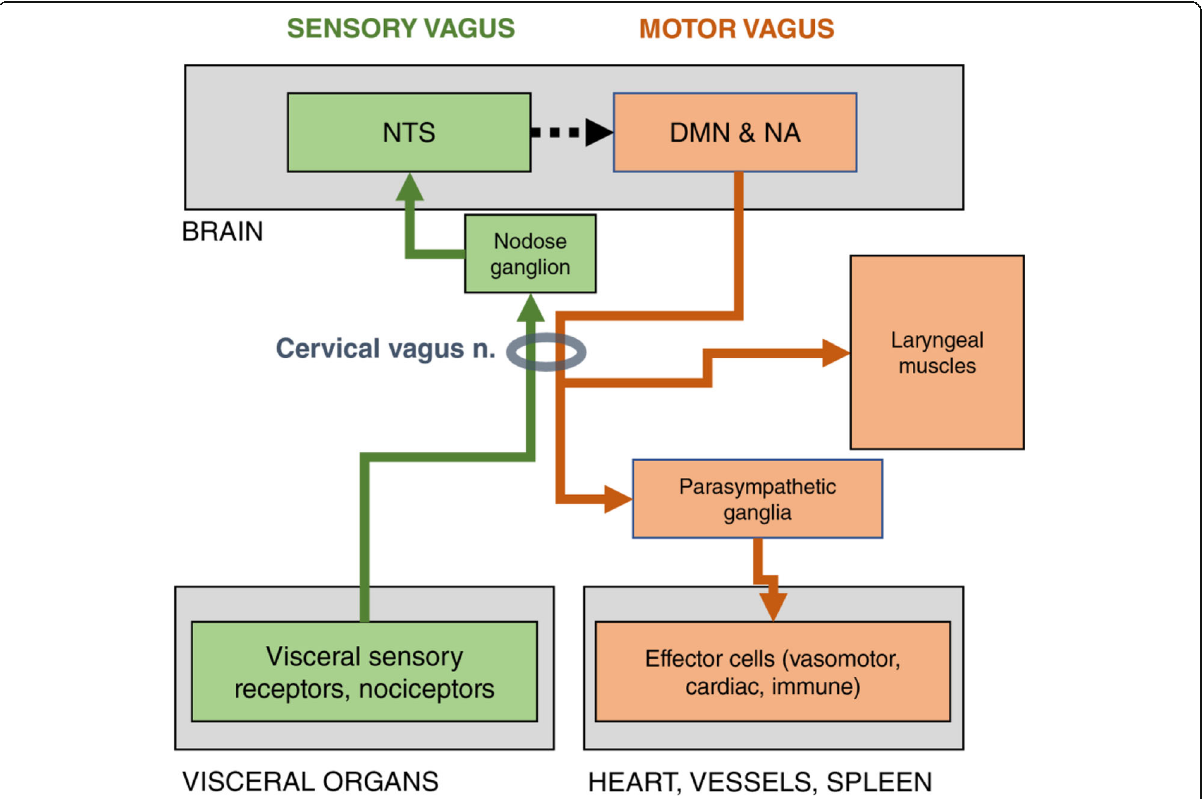
Fig. 1 Schematic diagram of the main central and peripheral components of the motor and sensory vagus. The vagus nerve includes sensory (afferent) and motor (efferent) arms, both of which are represented in the cervical region, where vagus cuffs are typically implanted. The sensory vagal pathway, shown in green, originates with general sensory receptors (i.e. nociceptors) in visceral organs, including vessels, the lungs, the heart, the gastrointestinal tract, the liver, lymph nodes etc. They convey information about mechanical parameters, e.g. increased wall tension in vessels in high blood pressure or in lung alveoli during inhalation, or biochemical events, e.g. presence of bacteria or inflammatory cytokines at an injured site. Afferent fibers from these receptors synapse at sensory neurons in the nodose ganglion of the vagus, located at the height of the transverse process of the first cervical vertebra. Axons of those sensory ganglionic neurons project to the nucleus of the solitary tract (NTS), in the brainstem. The motor vagal pathway, shown in red, originates in the motor nuclei of the vagus in the brainstem, the dorsal motor nucleus (DMN) and the nucleus ambiguous (NA). Peripheral axons of those cells go through the cervical vagus, and either innervate laryngeal muscles, or synapse on neurons in parasympathetic ganglia, close to organs like the heart, the lungs, the intestine, the pancreas, etc. An important target of the motor vagus is the spleen; in this case, motor vagal fibers synapse at the celiac ganglion, from which adrenergic fibers project to the